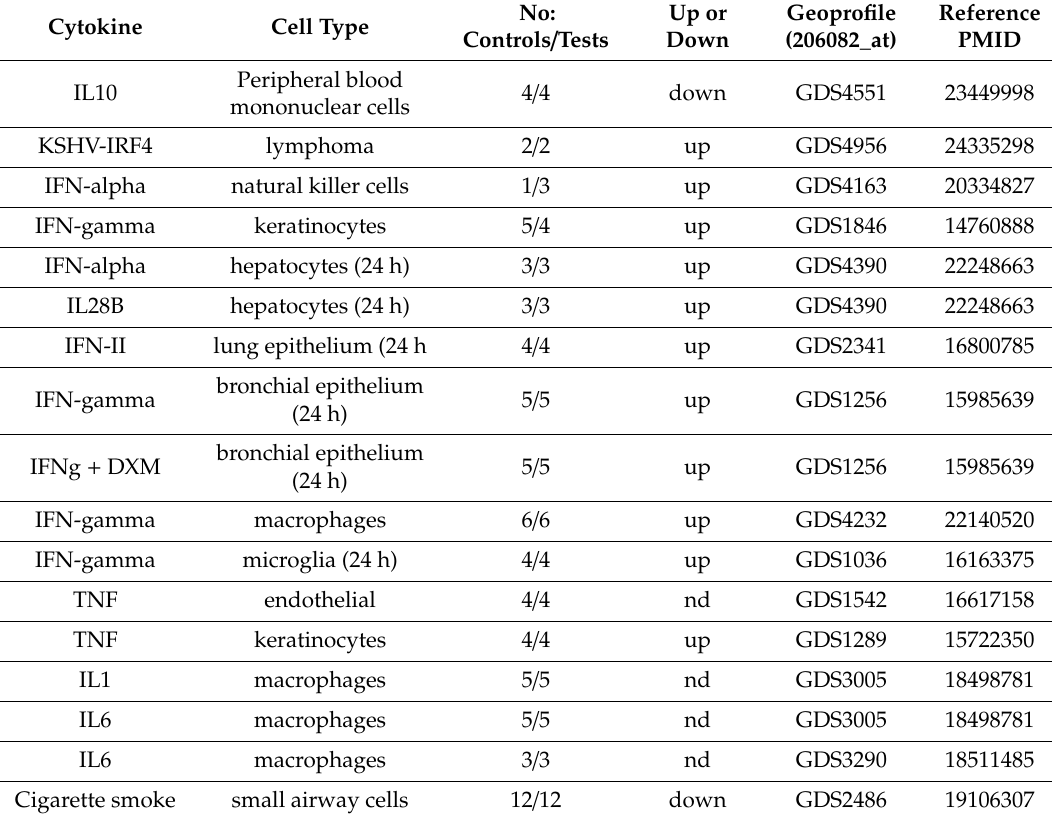
Table 2. E ff ect of interferons and cytokines on HCP5 RNA expression (nd, no di ff erence).